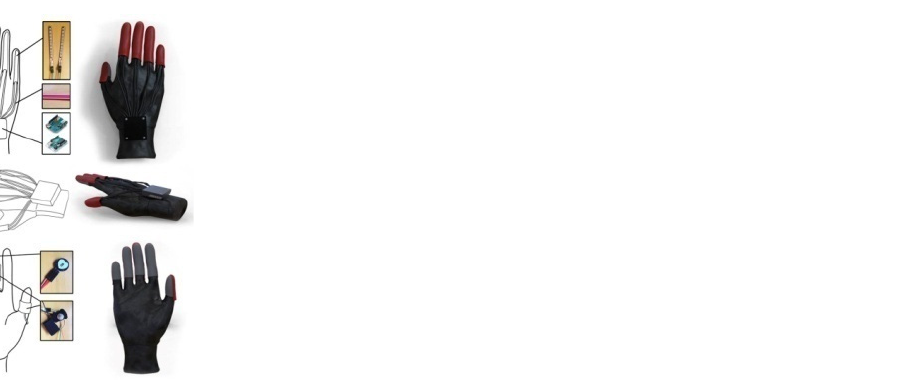
7 of 14 Figure 5. DN-1 composition of data glove module. Figure 6. Data glove hardware structure framework. The data acquisition module in the data glove mainly collects two kinds of data: one